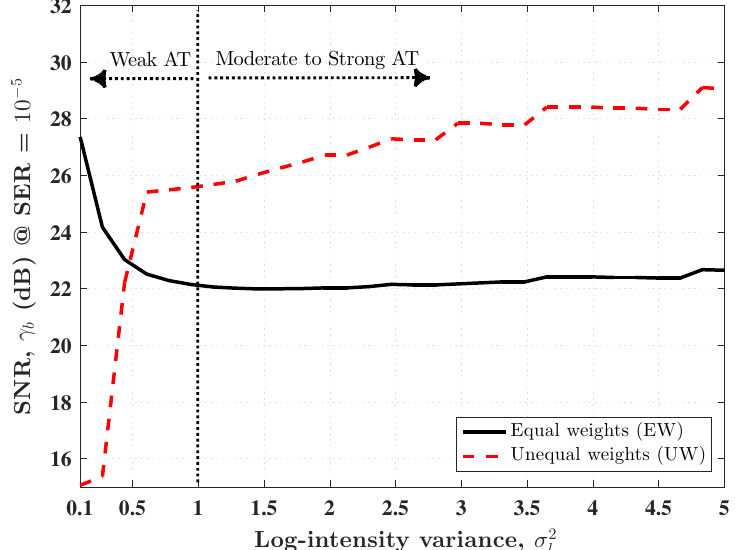
Figure 4. Performance under a varying AT regime. SNR required to achieve SER of 10 − 5 for the SPPM configuration: N t = 4, L =